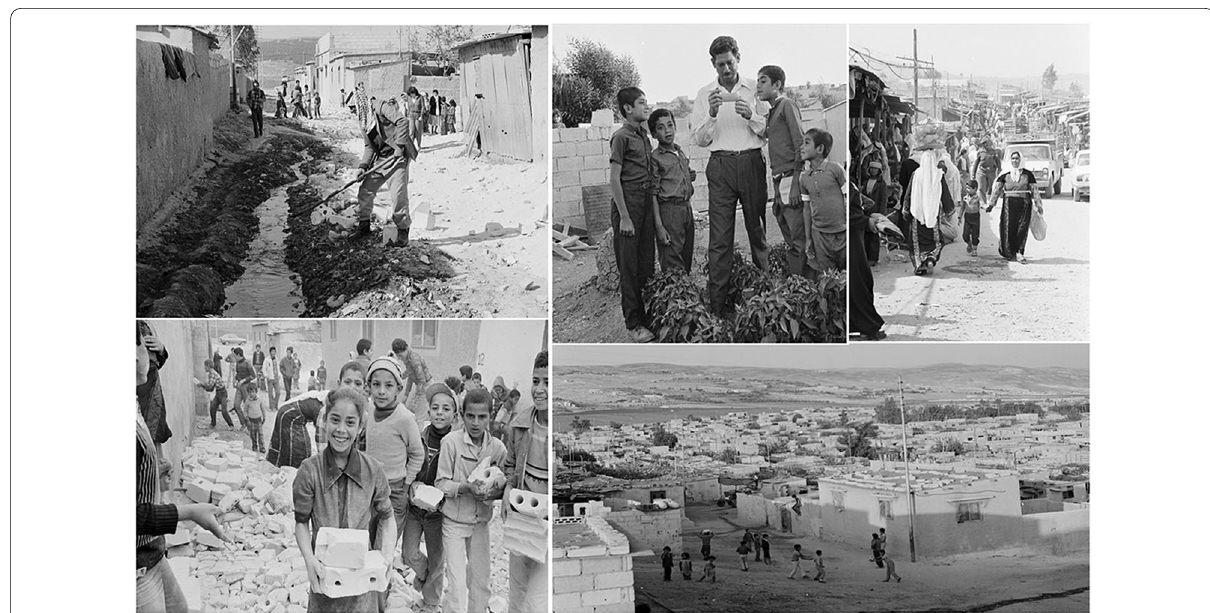
Fig. 10 (Top and bottom left) self-help project to improve the environment et al. Baqa’a camp, Jordan. © 1984 UNRWA archive photo by Shaukat Hasan; UNRWA archive photographer unknown; (top-middle right) a family has managed to grow a garden in the overcrowded Al Baqa’a camp ©